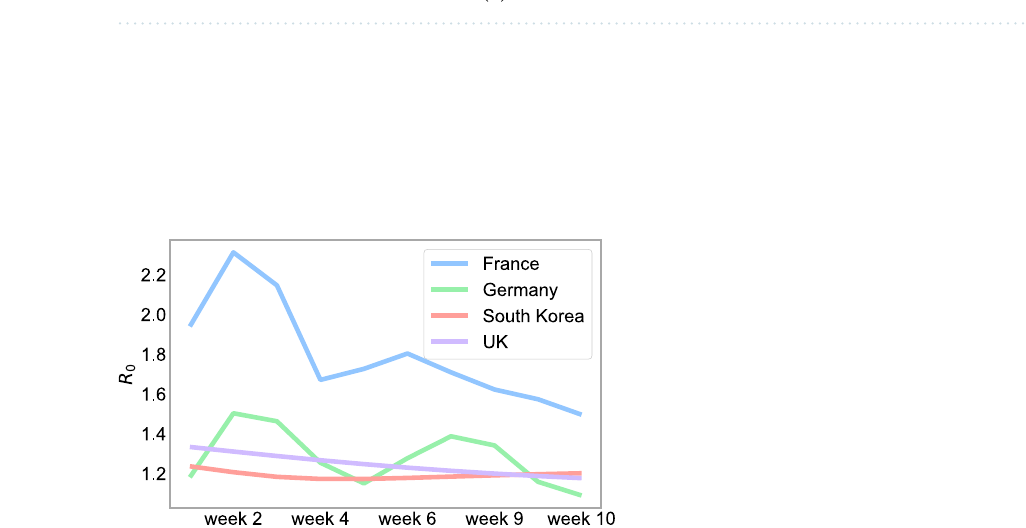
2 Table 1. Relative L errors with N T = 14 (2 weeks) for β and µ , and for the SIRD implementation with the LSTM networks. SIRD stands for susceptible (S), infectious (I), removed (R), deceased (D) individuals. The 2 definition of relative L error is stated in (1).